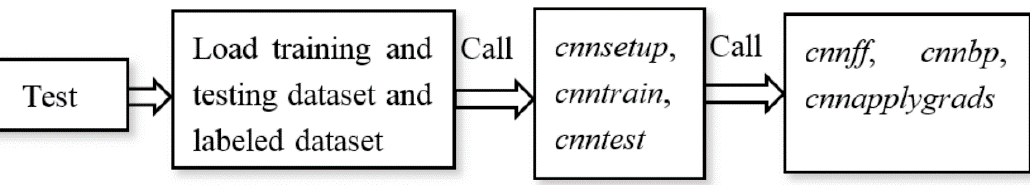
Figure 10. Pipeline modeling from [140] , Copyright 2018, MDPI.